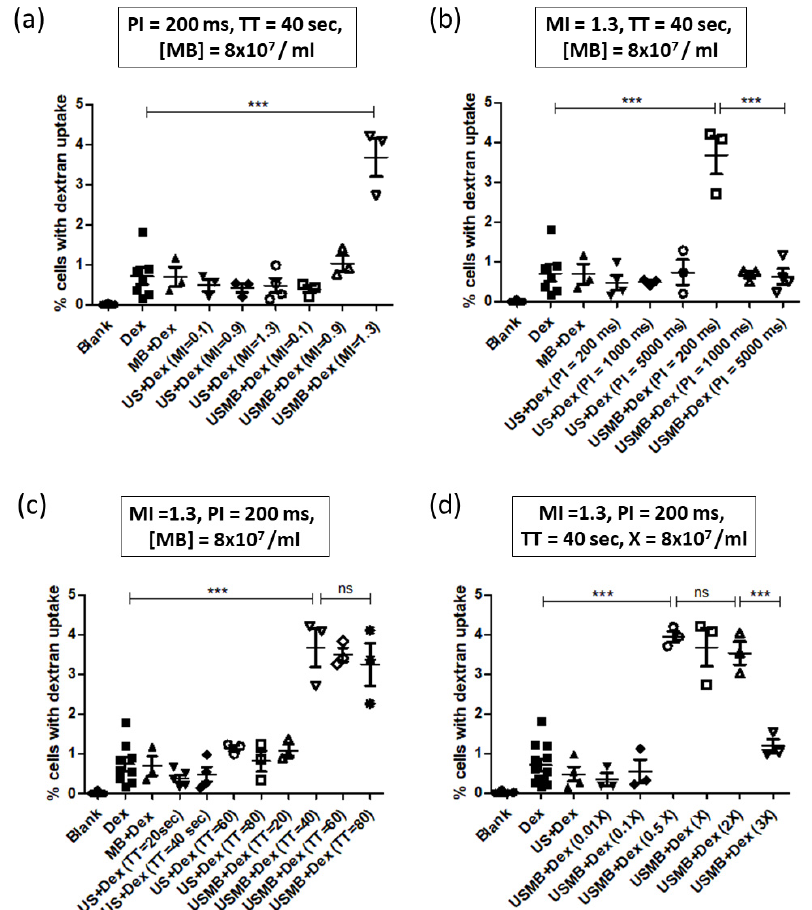
Figure 5. Optimization of 70 kDa dextran delivery in HEK293 cells by varying different experi- mental parameters. ( a ) Plot showing percentage of cells with dextran uptake for different treatment groups as a function of MI. The proportion of dextran positive cells increased significantly at MI of 1.3, compared to the controls ( p < 0.001). ( b ) Plot showing percentage of cells with dextran uptake for different treatment groups as a function of PI. The proportion of dextran positive cells increased significantly at 200 ms PI, compared to all the other groups ( p < 0.001). ( c ) Plot showing percentage of cells with dextran uptake as a function of ultrasound treatment time (TT). The proportion of dex- tran positive cells increased significantly at 40 sec TT ( p < 0.001). Increasing TT beyond 40 sec did not change in the proportion of dextran positive cells significantly ( p > 0.05). ( d ) Plot showing per- centage of cells with dextran uptake for different treatment groups as a function of the microbubble concentration (X = 8 × 10 7 bubbles/ml). The proportion of dextran positive cells increased signifi- cantly at 4 × 10 7 /ml concentration ( p < 0.001). Increasing the concentration to 8 × 10 7 /ml and 1.6 × 10 8 /ml did not change in the proportion of dextran positive cells significantly ( p > 0.05). Further increase in concentration leads to a significant decrease in the proportion of dextran positive cells ( p < 0.001). In all the experiments, coverslips were incubated for 10 min at 37 °C. One-way ANOVA with post-hoc Tukey’s test was used for assessing statistical significance in all the groups. In all the figures, *** represents p < 0.001.